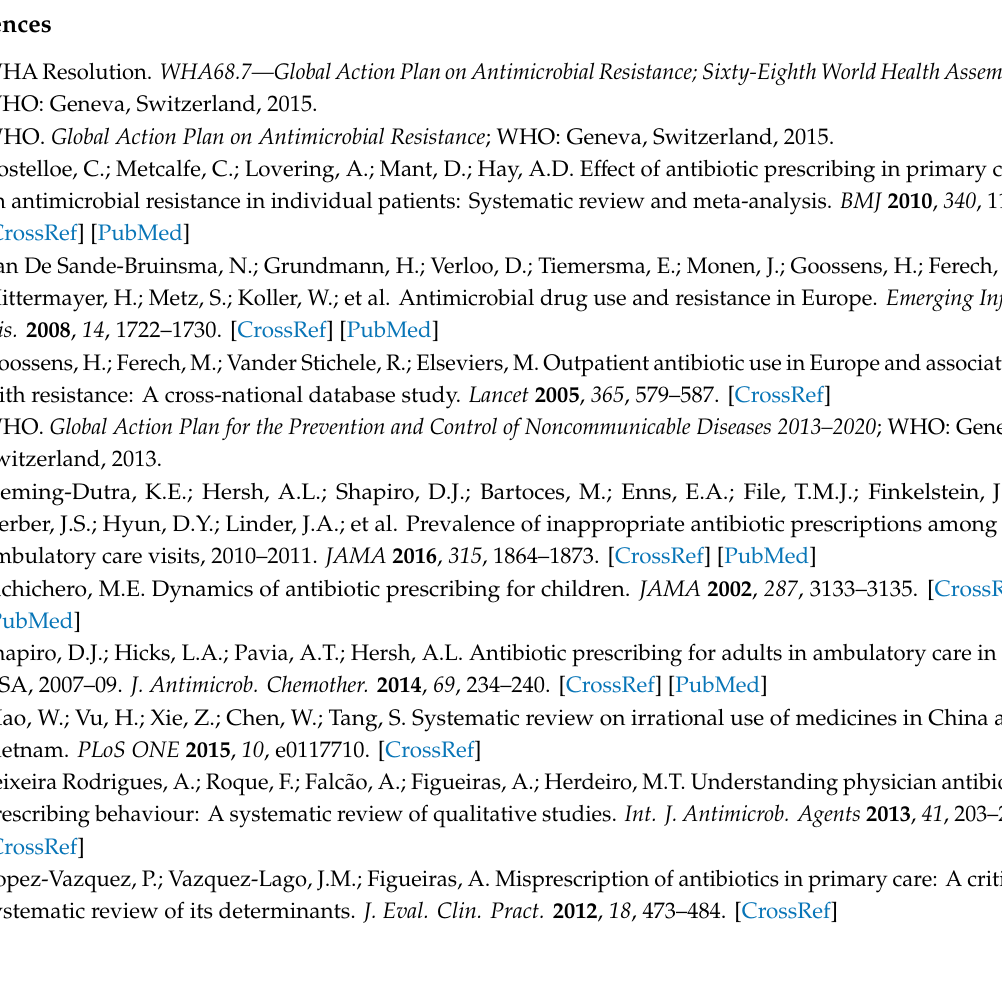
Figure S1. Development of the survey questionnaire; Table S1. Survey instruments (translated version); Table S2. Physicians’ responses to individual